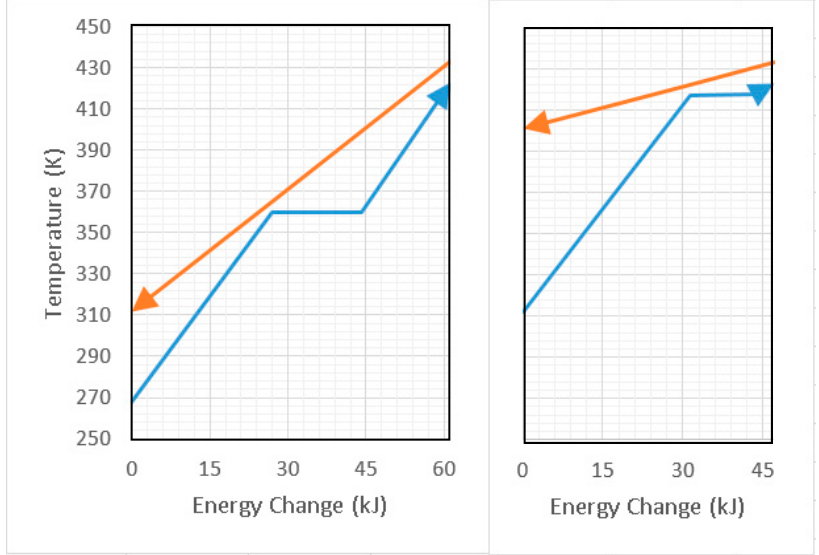
Figure 12. Evaporator Pinch Point Diagrams for a heat source temperature of 100 °C and heat sink temperatures of − 11 °C ( left ) and 25 °C ( right ).